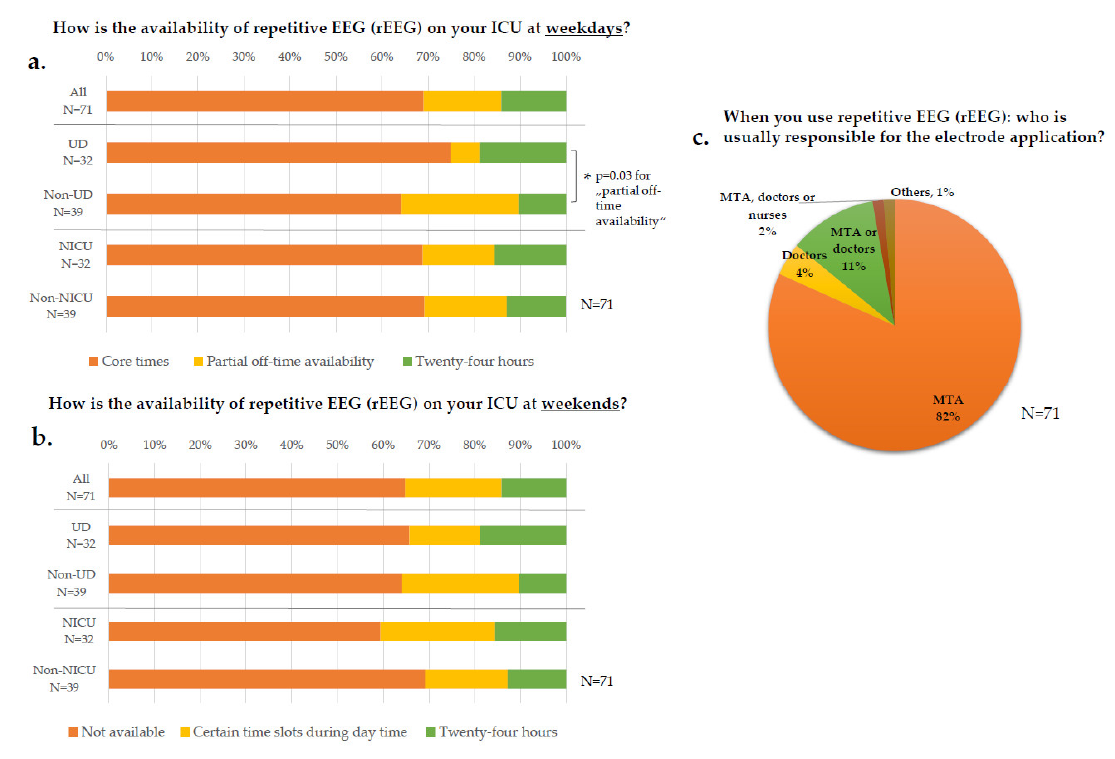
Figure 1. EEG diagnostics. ( a , b ): Participants had to choose one out of three possible answers marked by different colors; upper bars: all participants answering (“all“); 2nd and 3rd bar: answers of “all“ subdivided according to the level of care, 4th and 5th bar: according to ICU specialty. ( c ) Multiple answers were possible; there were no significant differences regarding department level of care or ICU specialty; MTA= medical technical assistant. Data are displayed as percentage of survey participants; N number of respondents; * = significant; UD = university department; Non-UD = Non-university departments; NICU = neurological/neurosurgical ICU; Non-NICU = non-neurological/neurosurgical ICU; ICU: intensive care unit; p -value: was determined by paired difference test via Z tests and the Bonferroni correction.